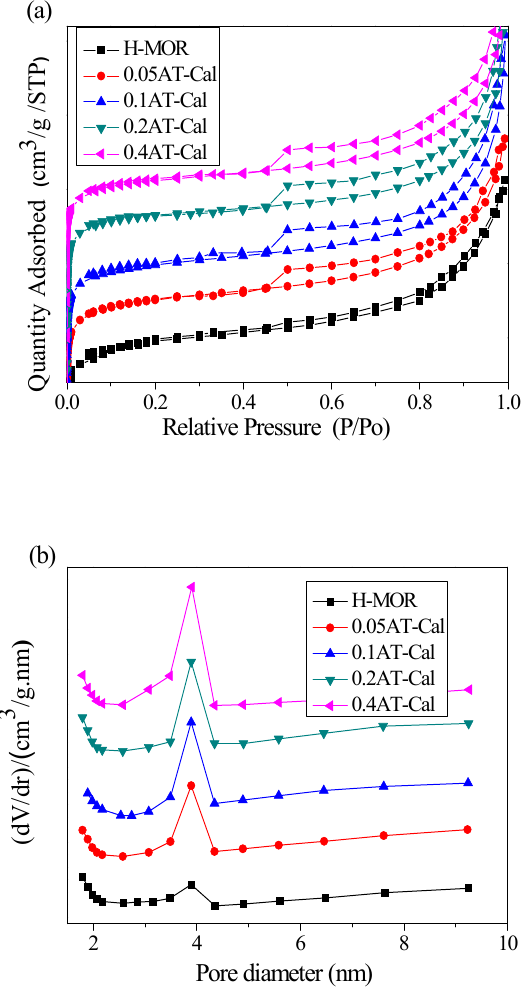
Figure 1. ( a ) N 2 adsorption / desorption isotherms of the samples before and after alkali treatment; ( b ) BJH pore size distributions of the samples before and after alkali treatment. Table 1. Physicochemical properties of the samples before and after alkali